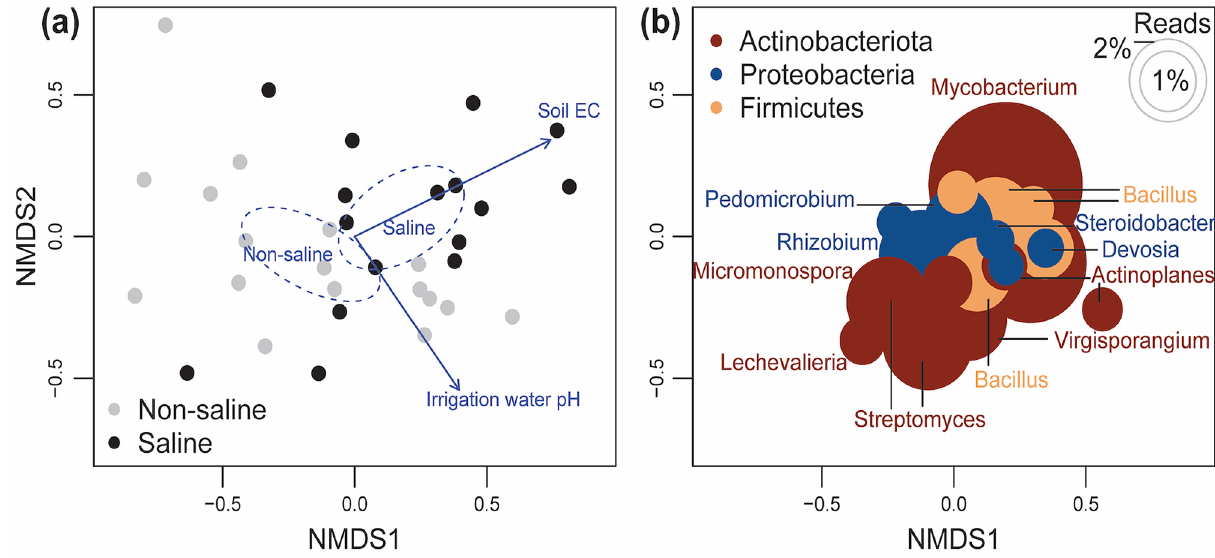
Figure 4. Non-metric multidimensional scaling (NMDS) ordination analysis for date palm roots-associated bacterial communities between irrigation sources (non-saline freshwater vs saline groundwater). ( a ) The sample-based ordination plot was generated from total Operational Taxonomic Units (OTUs) compositions. The different colours in a ( a ) are coded according to irrigation source, and in a panel, ( b ) coded according to bacterial phyla. The ellipse represents 95% confidence interval for the tested factor variable (i.e., irrigation source), and arrows point in the direction of maximum increase of individual vector variables and had significant effects ( P < 0.05) on the ordination configuration. ( b ) Species plots of overall bacteria was also based on total OTUs composition, but the most common 20 OTUs are visualized. The size of the circles in panel b shows the relative abundance of the OTUs.